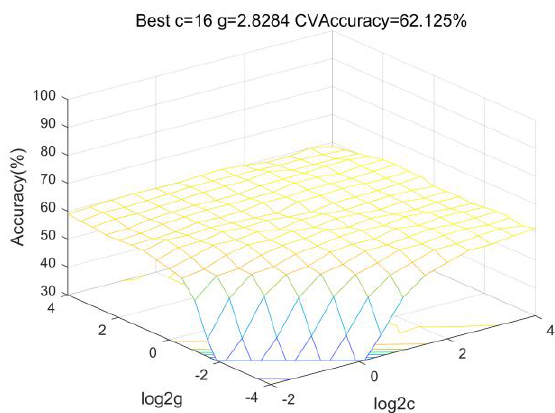
Figure 14. Identification results of support vector machine based on EMD.